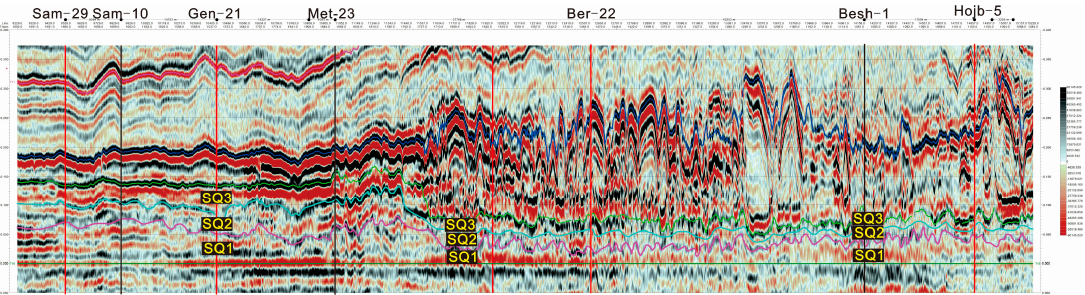
Figure 4. Lithological, chronostratigraphy and stratigraphic sequence of Callovian-Oxfordian Stage in Amu Darya Basin.